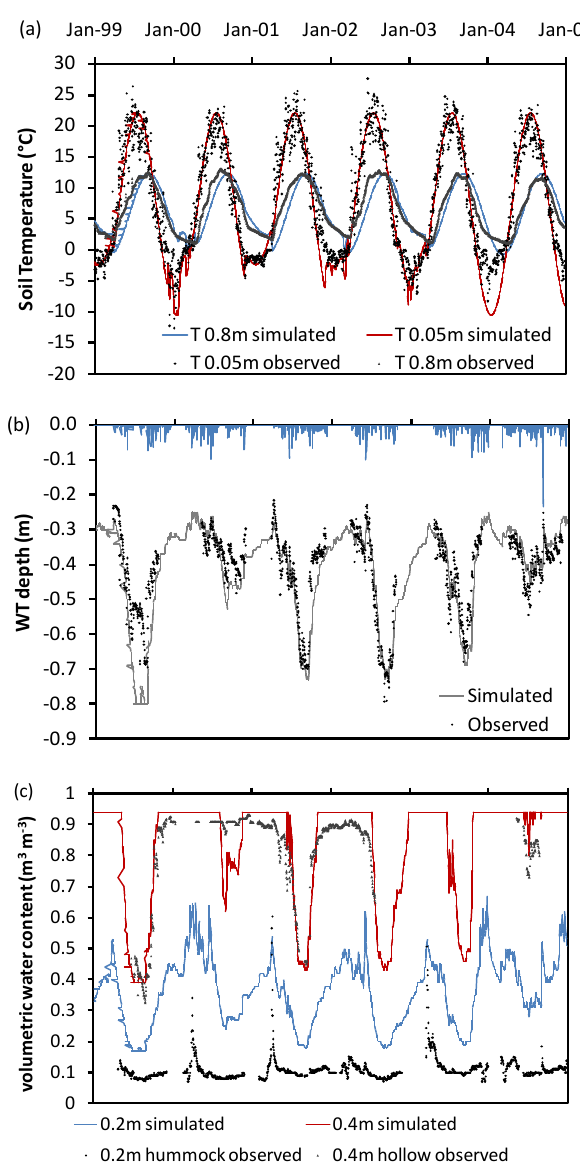
Figure 5. Time series of observed daily average (symbols) and daily simulated (lines) of temperature (a),water table depth (b),and volumetric water content (c) for 1999- 2004. The blue bars in (b) indicate observed daily precipitation records.